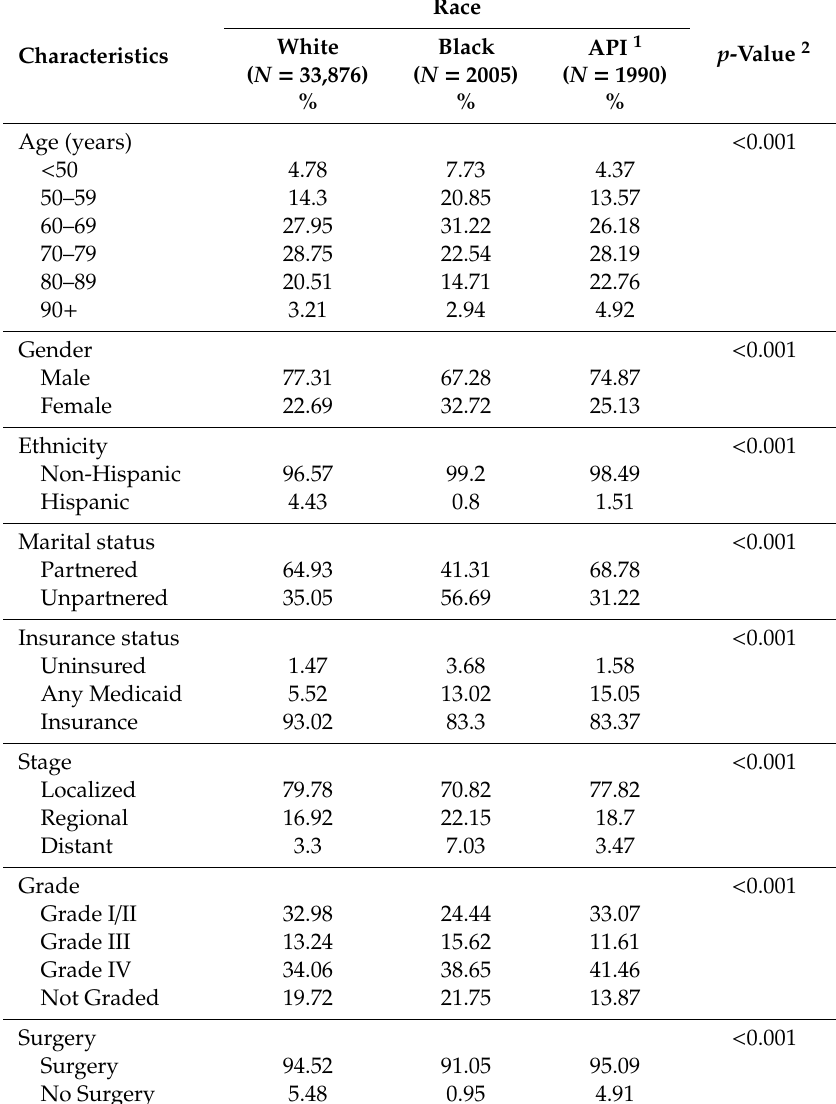
Table 1. Baseline characteristics of study participants with primary urinary bladder cancer according to race during